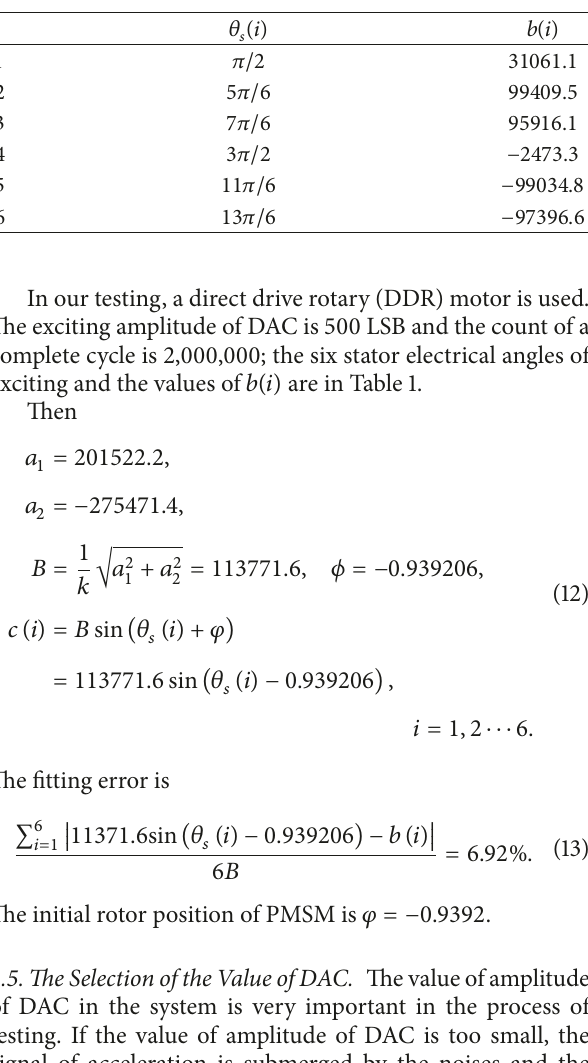
Table 1: Stator electrical angle of exciting and the values of 𝑏(𝑖) .